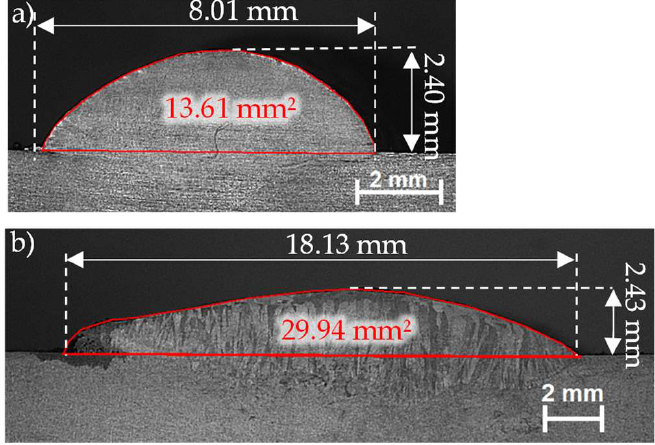
Figure 7. Cross-section of single weld seam of conventional PTA ( a ) and tandem PTA stringer ( b ).